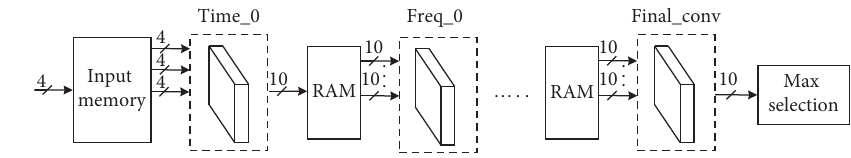
Figure 6: SCNN architecture for FPGA implementation.